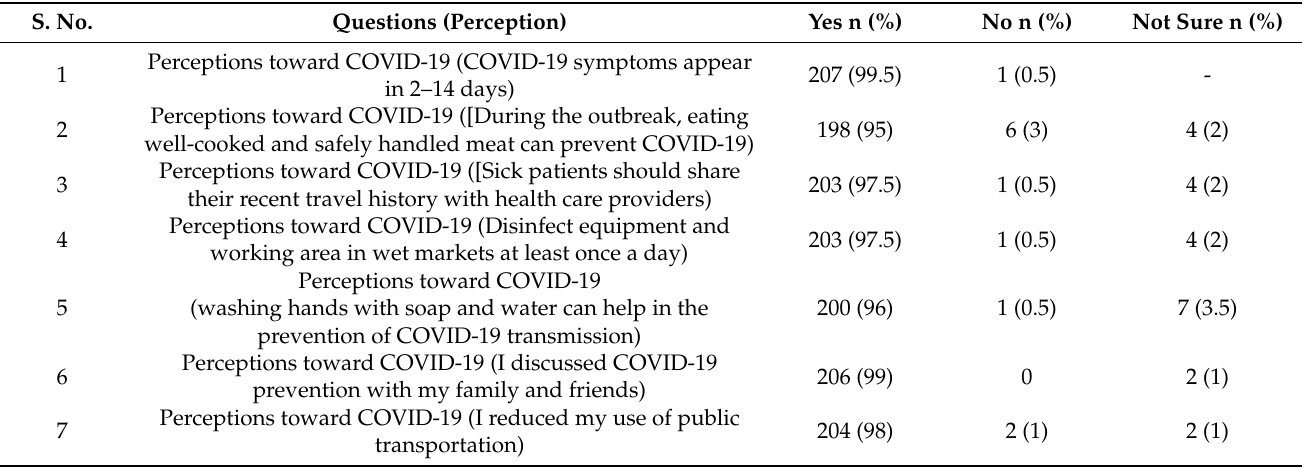
Table 4. Perception and attitudes towards COVID-19 (N =